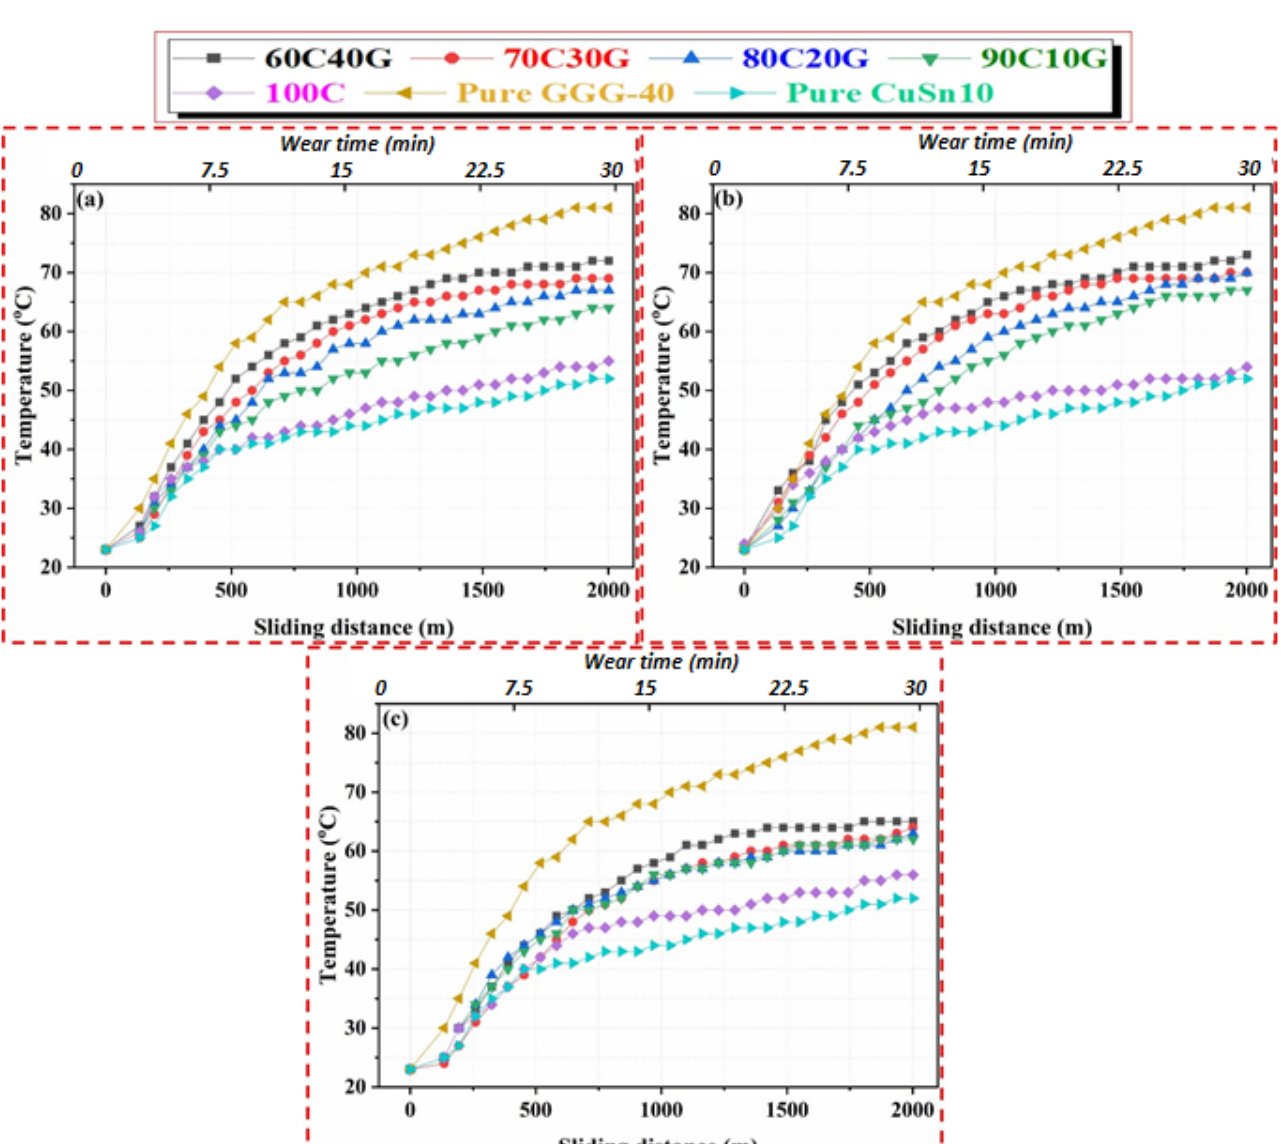
Figure 9. Contact zone temperature changes of ( a ) 480 MPa, ( b ) 640 MPa, and ( c ) 820 MPa MMCs produced at 450 °C according to sliding distance and wear time.